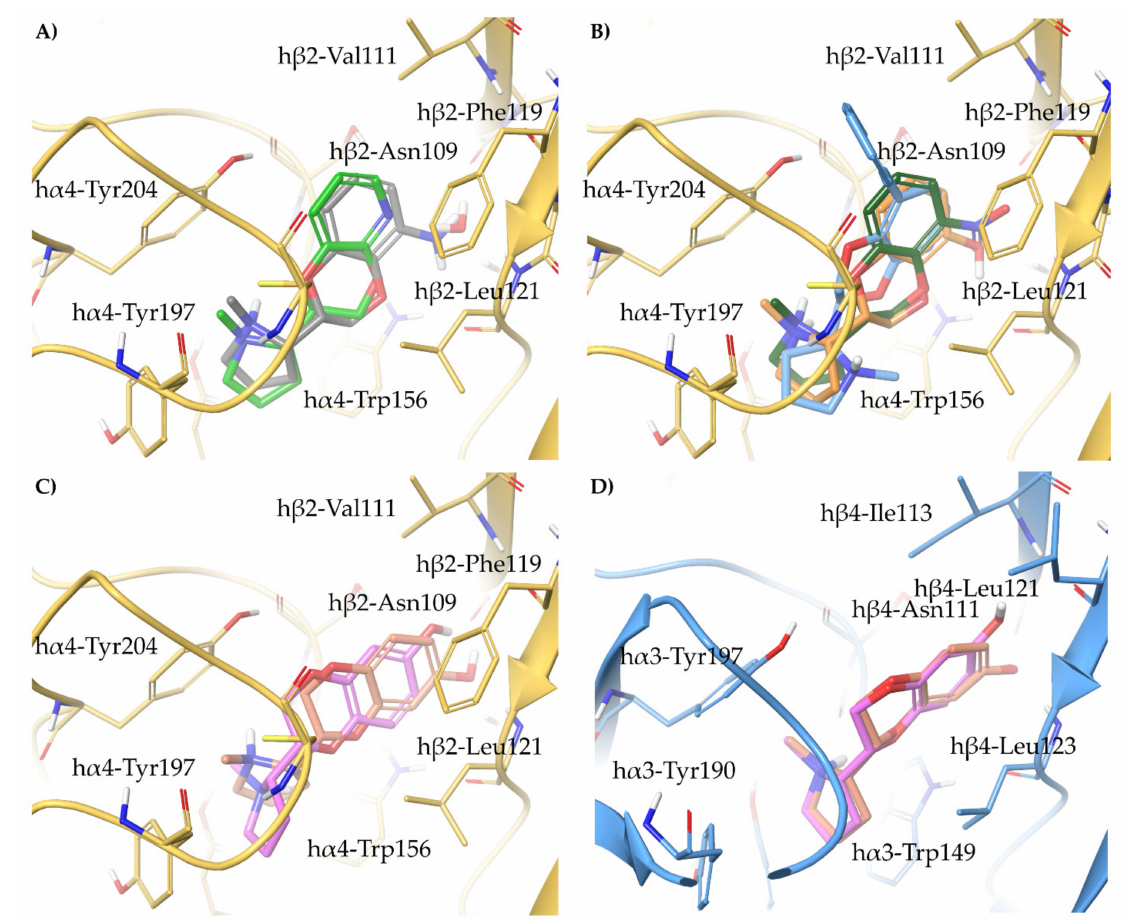
Figure 11. ( A ) Similar binding poses of ( S , R )- 33 (green) and ( S , S )- 37 (grey) at the h α 4 β 2 nAChR, retraced by ( B ) ( S , S )- 38 (dark green) and ( S , S )- 39 (orange), but not by ( S , S )- 40 (light blue). ( C ) Superimposition of the binding modes of ( S , R )- 2 (faded orange) and ( S , R )- 43 (pink) at the h α 4 β 2 and ( D ) h α 3 β 4 nAChRs binding